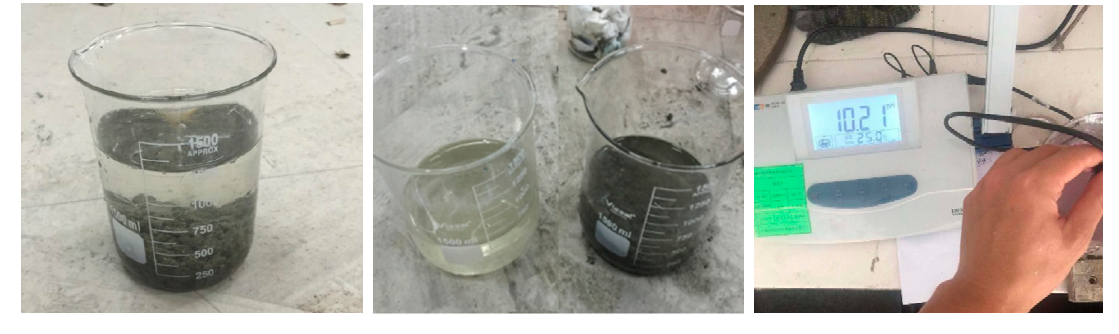
Figure 5. Test of anti-dispersity.